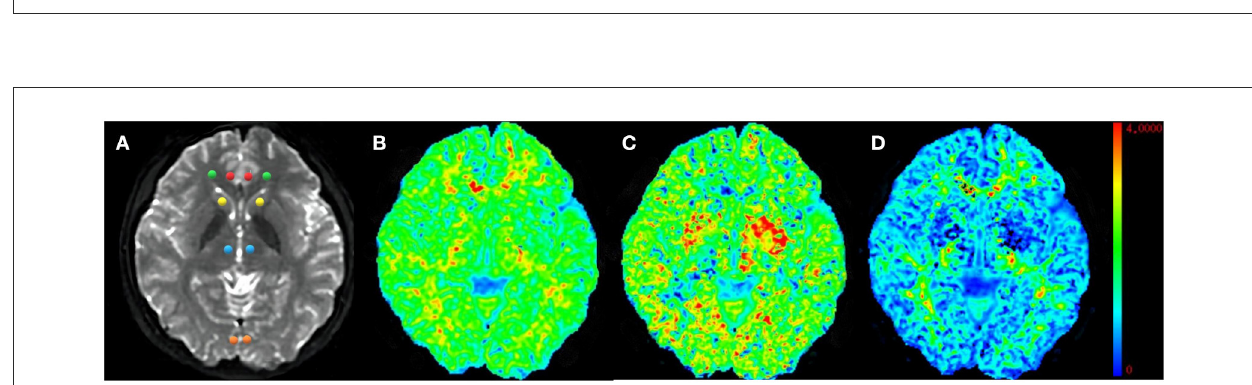
FIGURE1 Representative proton magnetic resonance spectroscopy ( 1 H-MRS) spectra for the anterior cingulate cortex (red square) in different groups. Region of interest (ROI) is shown in axial T1-weighted imaging (T1WI) (A) , the healthy control group (B) , the unipolar depression group (C) , and the bipolar disorder group (D) .